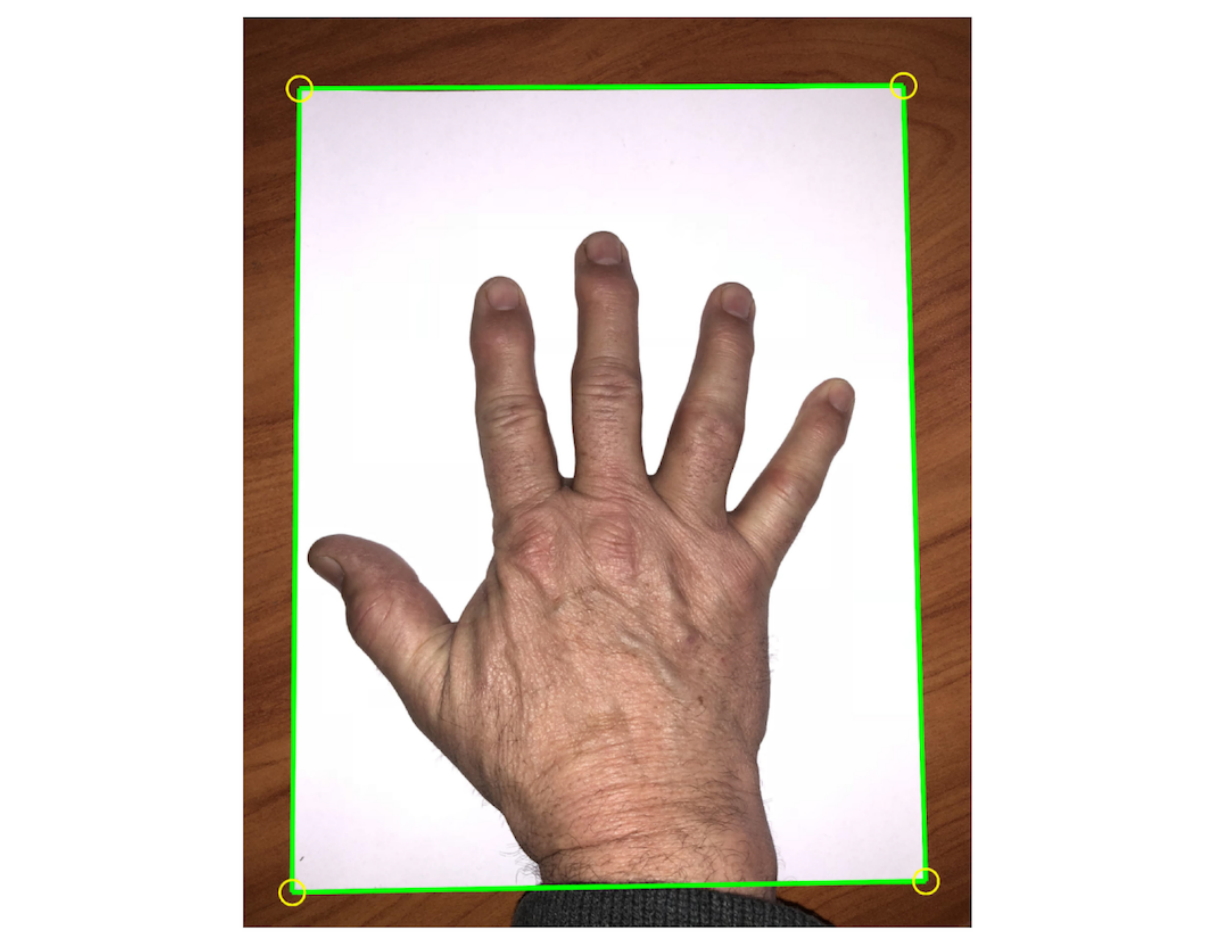
Figure 5. Imaging hand calibration requirements include (1) all 4 corners of the paper are in the photo, (2) the hand is within the paper's edges, (3) fingers are spread, and (4) the background behind the paper is darker and free of clutter.